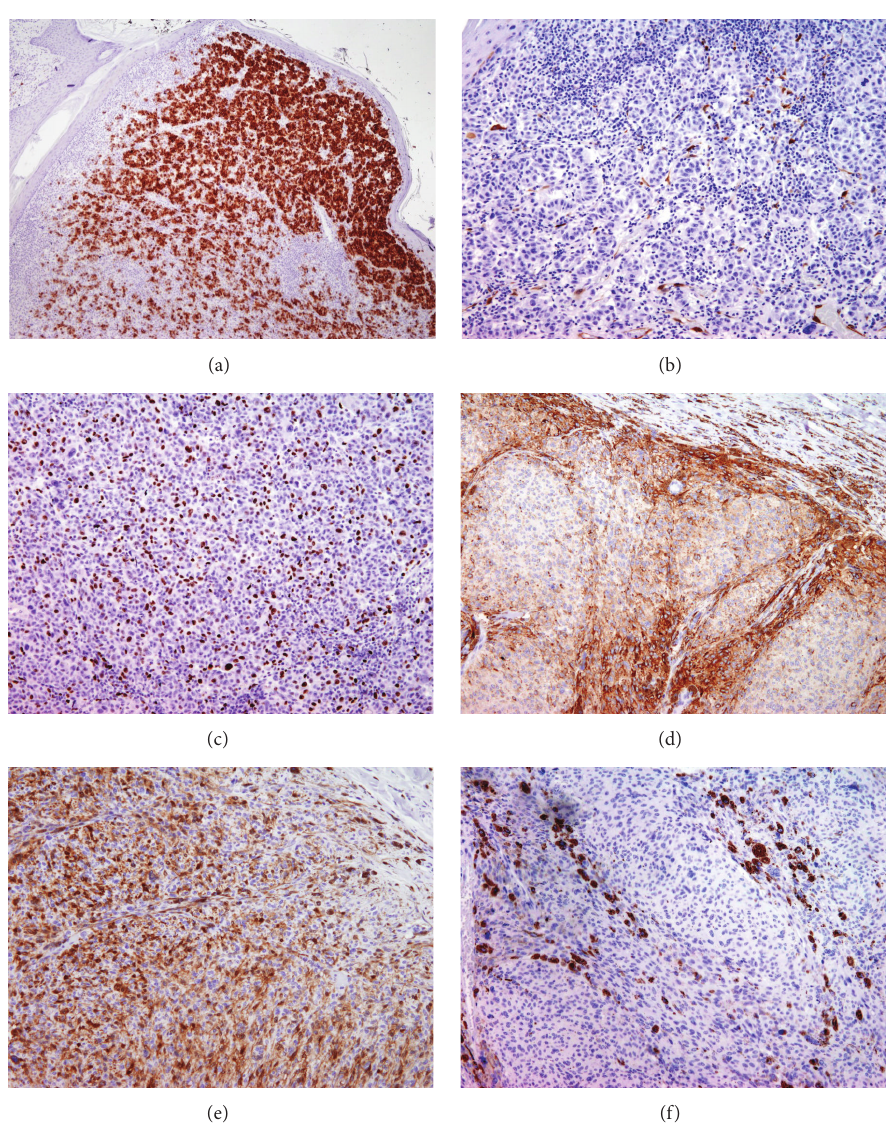
Figure 3: Immunohistochemical staining of nodular melanoma (NM) and cellular blue nevus (CBN) with HMB-45, p16, and Ki-67: HMB-45 was strongly positive in NM (a) while in CBN the reactivity was mostly present at the periphery of alveolar nets (d); p16 was negative in NM (b) but present in the majority of tumor cells in CBN (e); Ki-67 was positive in 33% of melanoma cells (c) and negative in CBN